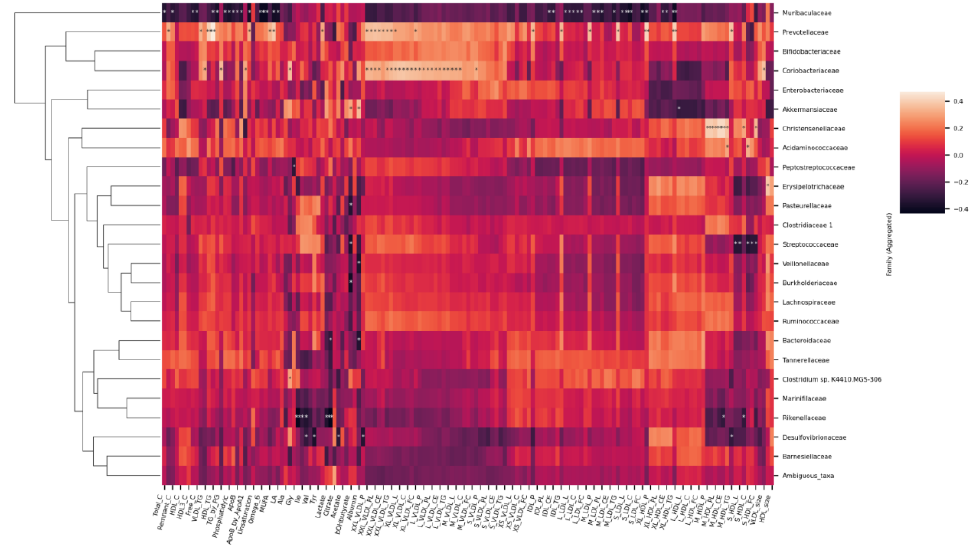
Figure 9. Heatmap of Spearman correlation coefficients between the serum metabolites and gut mi- crobial families. Spearman p value * < 0.05 ** <